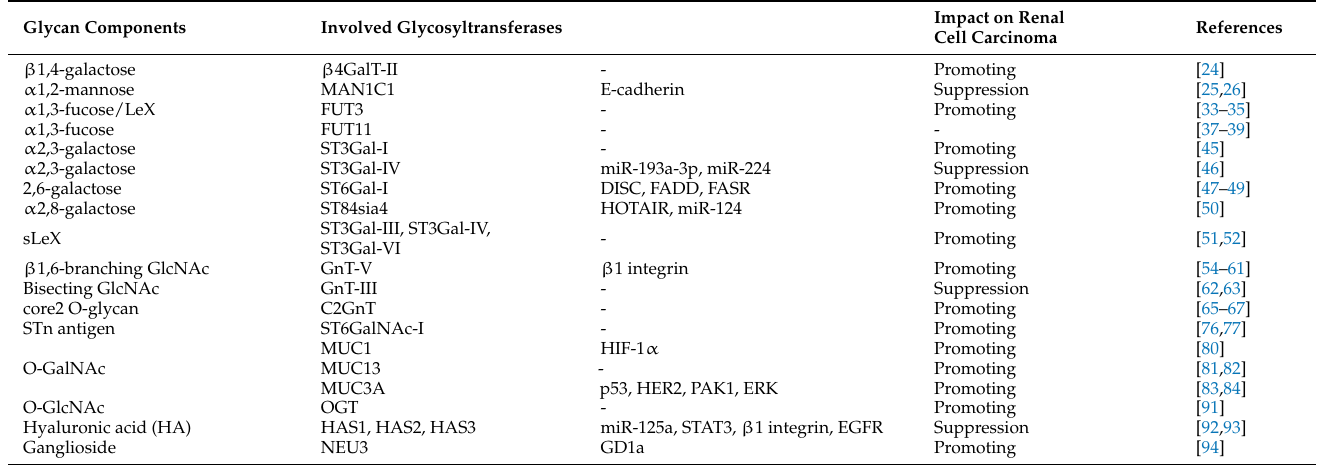
Table 1. Glycosylation and its functions in renal cell